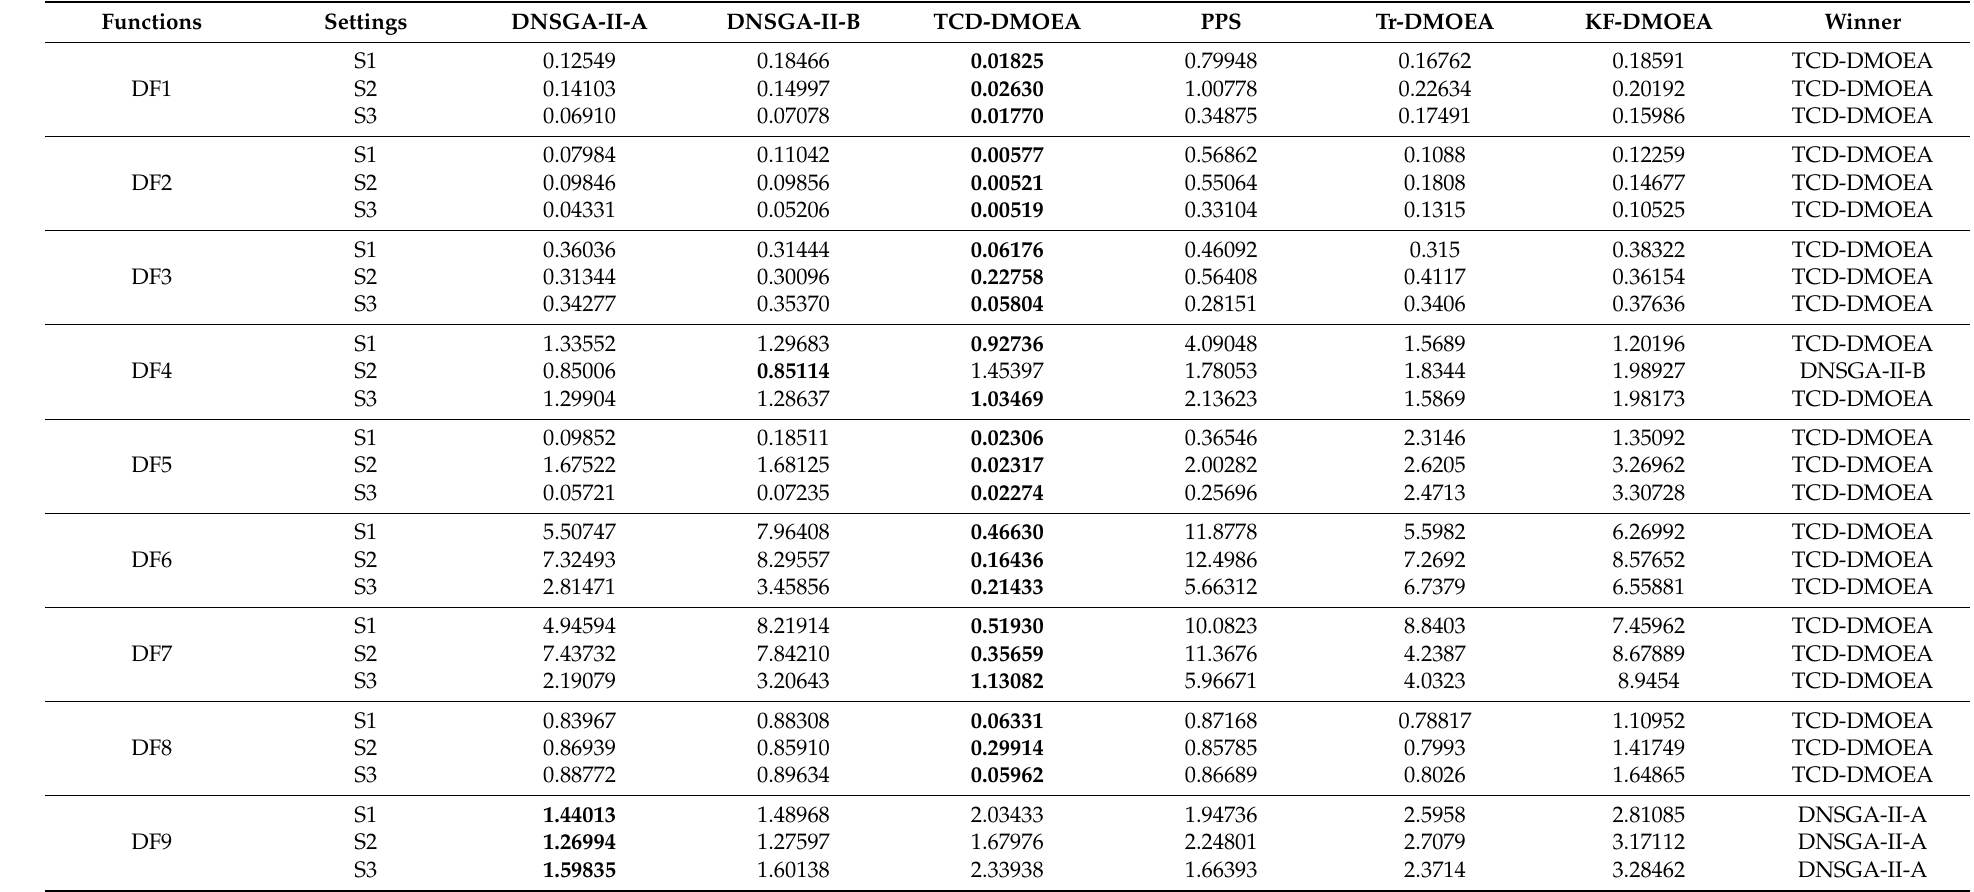
Table 2. The MIGD values of six comparative algorithms with different dynamic test settings.